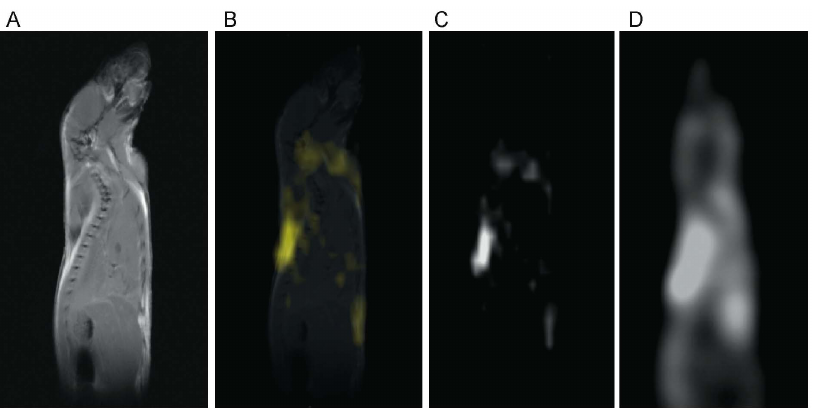
Figure 4. Correlation between BATSCI maps and the BAT activity maps obtained with 18 F-FDG-PET. ( A ) Anatomical sagittal spin echo MR image of a young C57 mouse. ( B ) BATSCI map of the same mouse overlapped to the anatomical image. ( C ) BATSCI map showing the interscapular brown fat area as well other BAT depots near the neck ( D ) BAT activity map obtained by 18 F-FDG-PET of the same mouse acquired after BAT stimulation. 18 F-FDG-PET scans show active BAT as well as other metabolically active (heart and brain) tissues, but not inactive BAT.